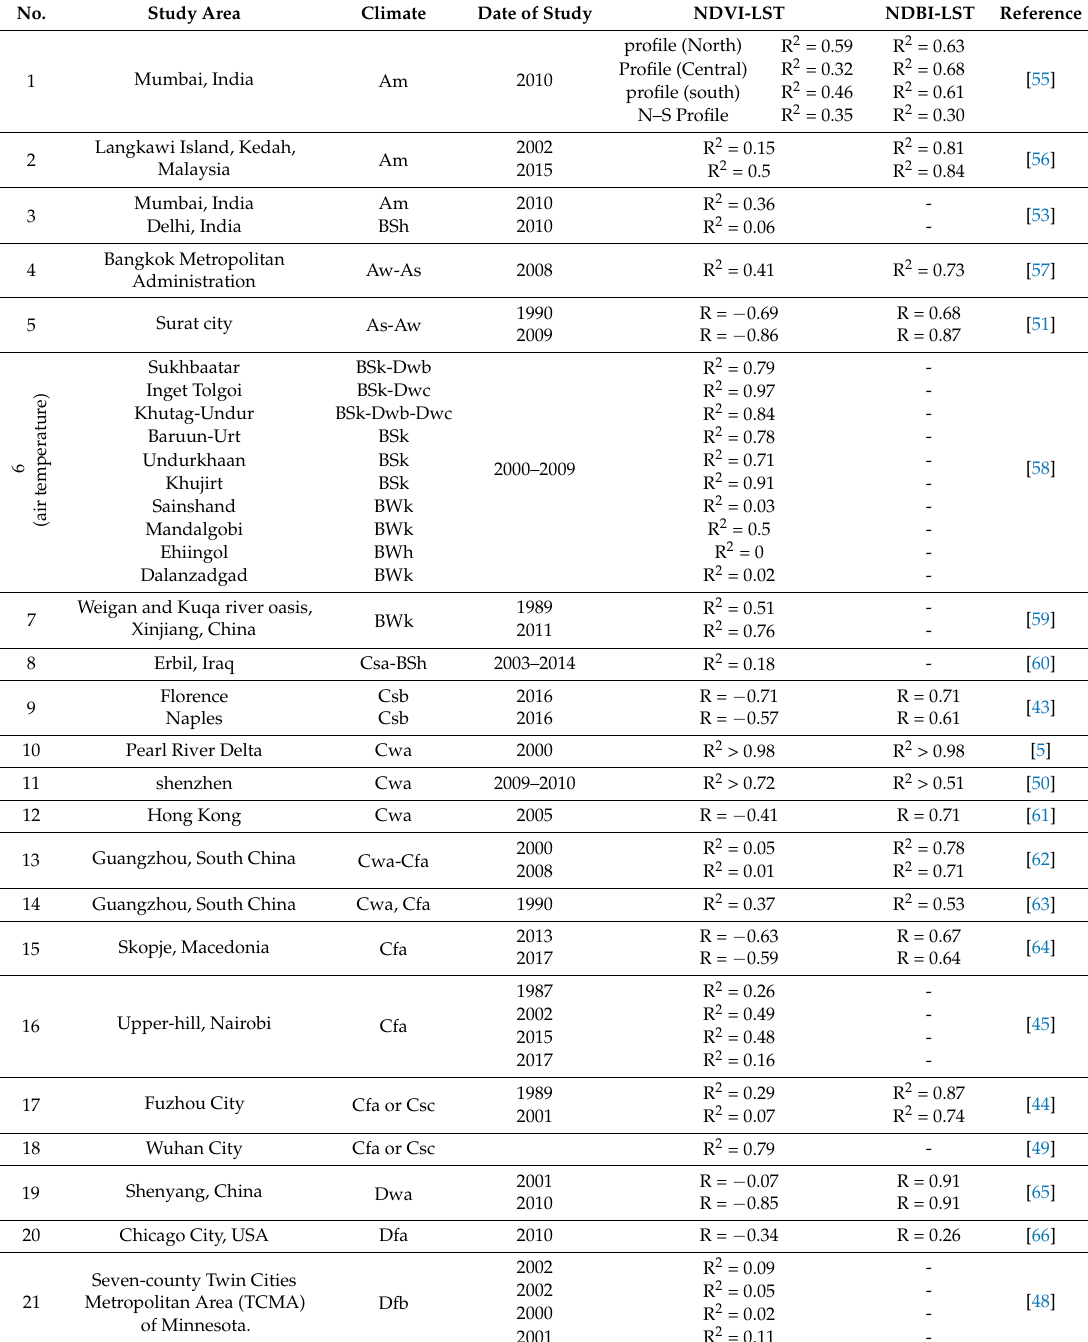
Table 7. The correlation of NDVI-LST and NDBI-LST relationships of previous case studies in various climate